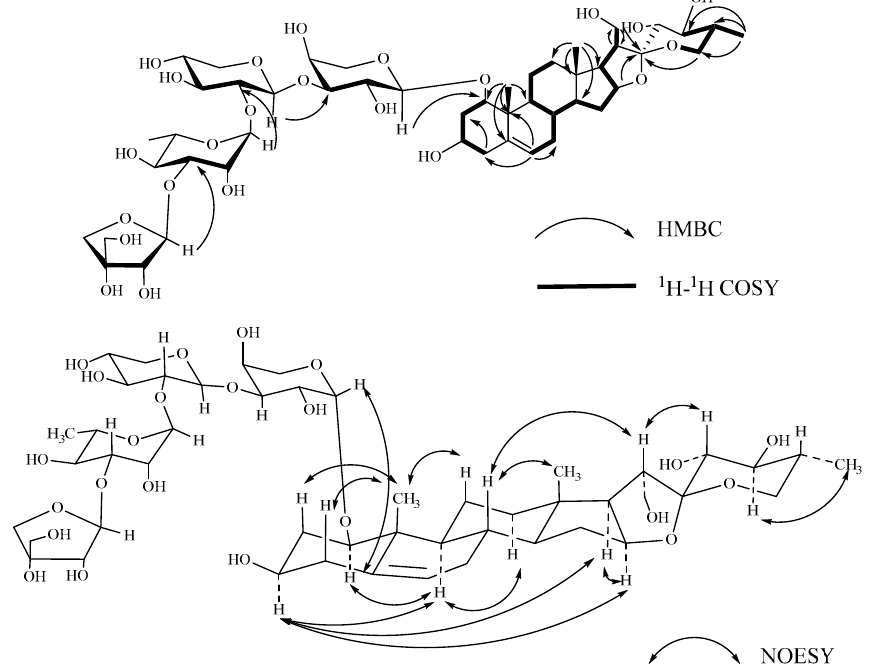
Figure 3. Key 1 H- 1 H COSY, HMBC, and NOESY correlations of compound 2 . Compound 3 , named Pamaiosides C, a white amorphous solid, was positive to Liebermann Burchard and Molisch chemical reactions. The pseudomolecular ion peak was measured in the HR-ESI-MS spectrum at m/z 993.3932 [M + Na] + (calculated for C 46 H 66 O 22 Na, 993.3943), corresponding to the molecular formula C 46 H 66 O 22 . Compared to 2 , one angular methyl δ C 17.30 (C-18) was missing and two quaternary carbons, δ C 179.23 (C-13) and 139.51 (C-14), and one ketone δ C 207.09 (C-15) signal were detected (Table 1– 4). In the HMBC spectra, the cross-peaks between δ Ha 1.19, δ Hb 2.94 (H-11)/ δ Ha 2.36, δ Hb 2.60 (H-12)/ δ H 2.34 (H-17)/ δ H 4.38 (H-16) and δ C 179.23 (C-13), between δ H 2.26 (H-8)/ δ Ha 1.48, δ δ Hb 2.87 (H-7), and C 139.51 (C-14) allowed to deduce that one double bond was located at C-13/C-14. Moreover, the location of δ C 207.09 (C-15) was affirmed by correlation of δ H 2.34 (H-17) to δ C 207.09 (C-15) (Figure 4). As a result, the aglycone of 3 was determined as 15-oxo-18-nor-(20 R ,22 R ,25 R )-spirost-5,13-diene-1 β ,3 β ,21,23 α ,24 β -pentol [23]. The monosaccharide residues were identified as L-Ara, L-Rha, and D-Api in a ratio of 1:1:1 by acid hydrolysis, derivatization, and GC analysis. In addition, two keto-methyls at δ C 21.15 (3H, s , δ H 2.12) and 21.02 (3H, s , δ H 2.02) and two carbonyl at δ C 172.29 and 171.96 carbons signals were observed, which infers that two acetyl groups existed in the sugar chain. In the HMBC spectrum, one proton of keto-methyl at δ H 2.12 was correlated with one carbonyl carbon signal at δ C 172.29 and δ C 74.65 (C-4, Rha); moreover, H-4 of Rha ( δ H 4.95) was correlated with δ C 172.29, suggesting that one acetyl was connected at C-4 of Rha. In the same way, another acetyl was substituted at C-2 of Rha, elaborated by the cross-peaks between δ H 2.02 and δ C 171.96/ δ C 73.46 (C-2, Rha) and between δ H 5.29 (H-2, Rha) and δ C 171.96. Compared to 2 , it was further confirmed by the up-field shifts of δ H 5.29 (H-2 of Rha, ∆ δ C + 1.2 ppm) and δ H 4.95 (H-4 of Rha, ∆ δ C + 1.43 ppm). The β configu- ration of D-apiose affirmed the chemical shifts of δ C 112.54 (C-1), 78.49(C-2), 80.68(C-3), 75.41 (C-4), and 65.56 (C-5) [20]. The a configuration of L-rhamnopyranosyl was confirmed by the chemical shifts of Rha C-5 at δ C 67.34 [21]. The anomeric proton coupling constants of L-arabopyranose ( J = 7.6 Hz > 7.0 Hz) suggests that the configuration was an α orienta- tion [19]. Thus, compound 3 was determined as 15-oxo-18-nor-(20 R ,22 R ,25 R )-spirost-5,13- diene-1 β ,3 β ,21,23 α ,24 β -pentol-1- O - β - D -apiofuranosyl-(1 → 3)-2,4-diacetyl- α - L -rhamnopy- ranosyl-(1 → 3)- a - L -arabinopyranoside.